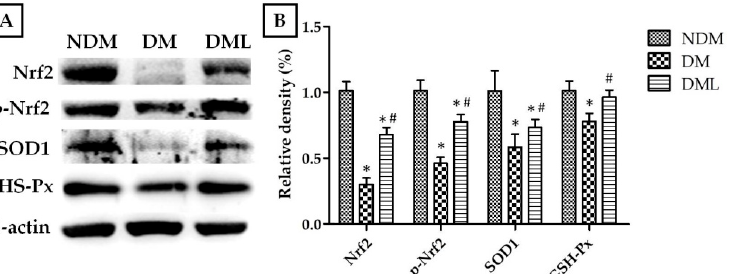
Figure 6. Effects of luteolin on protein expression levels of oxidative enzymes of the skin wound on day 14. ( A ) Tissues were homogenized in RIPA buffer, subjected to immunoblotting with anti- Nrf2, anti-phospho-Nrf2, anti-SOD1, and anti-GSH-Px antibodies. ( B ) Quantitative results of Nrf2, # p < 0.05, compared with the DM group.